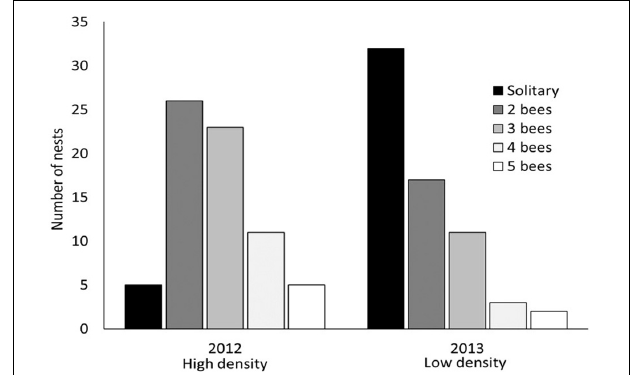
FIGURE 1 | Variation in group size during the brood provisioning phase of the colony cycle in response to high (2012) and low (2013) population density. In low density, significantly more females nested solitarily ( Table 1 , P < 0.00001, also see Supplementary Table 1 ). In both 2012 and 2013, the maximum colony size during the brood provisioning phase was 5